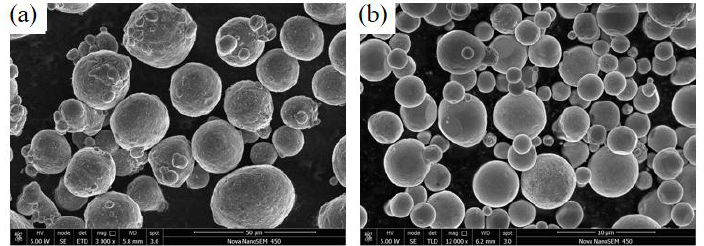
Figure 1. Particle morphology diagram: ( a ) aluminum particles, ( b ) zinc particles. Table 2. Chemical composition of substrate (wt.%).